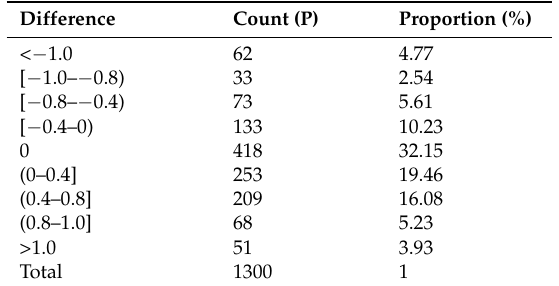
Data on differences in the population results are collected, and the results are shown in Table 6. Table 6. Statistics of Population Differences on the Different